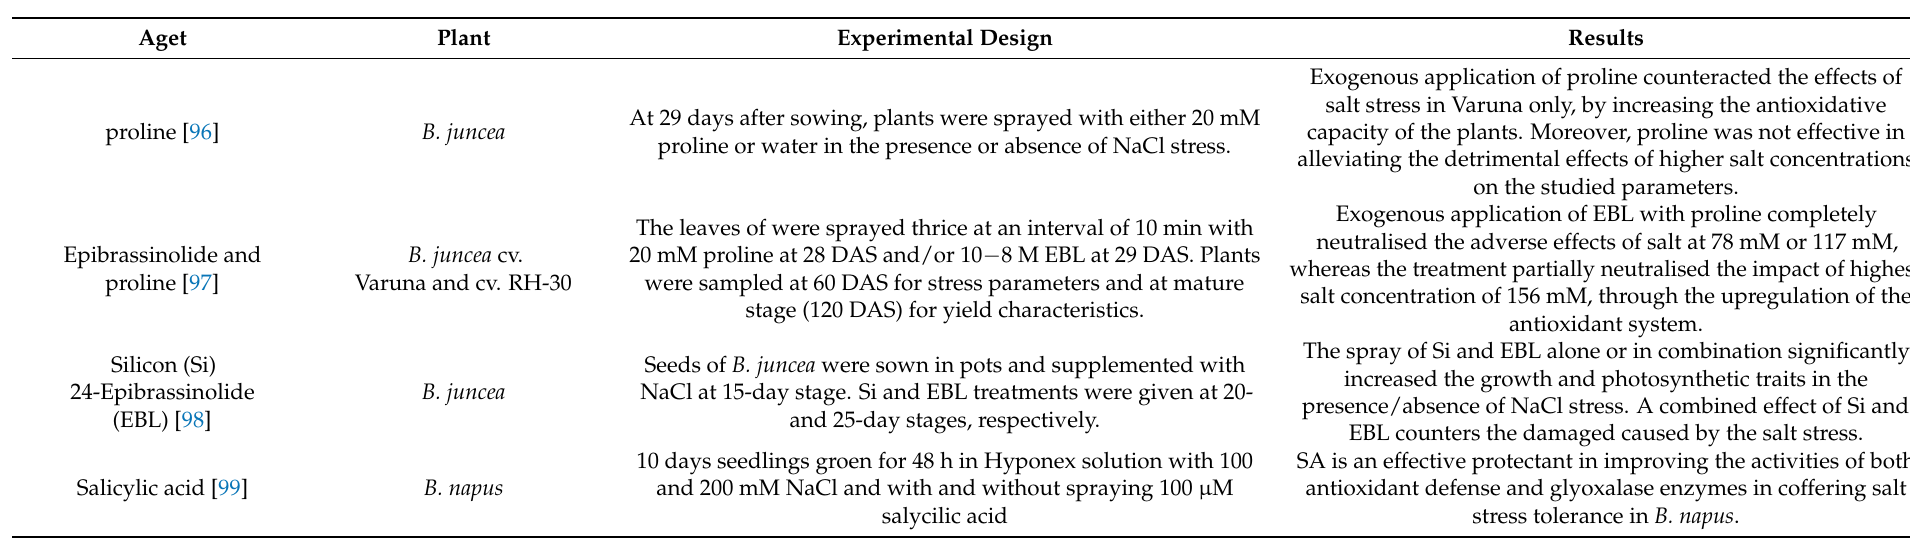
Table 3. List of foliar treatments with molecules and their beneficial effect on Brassica plants under salt